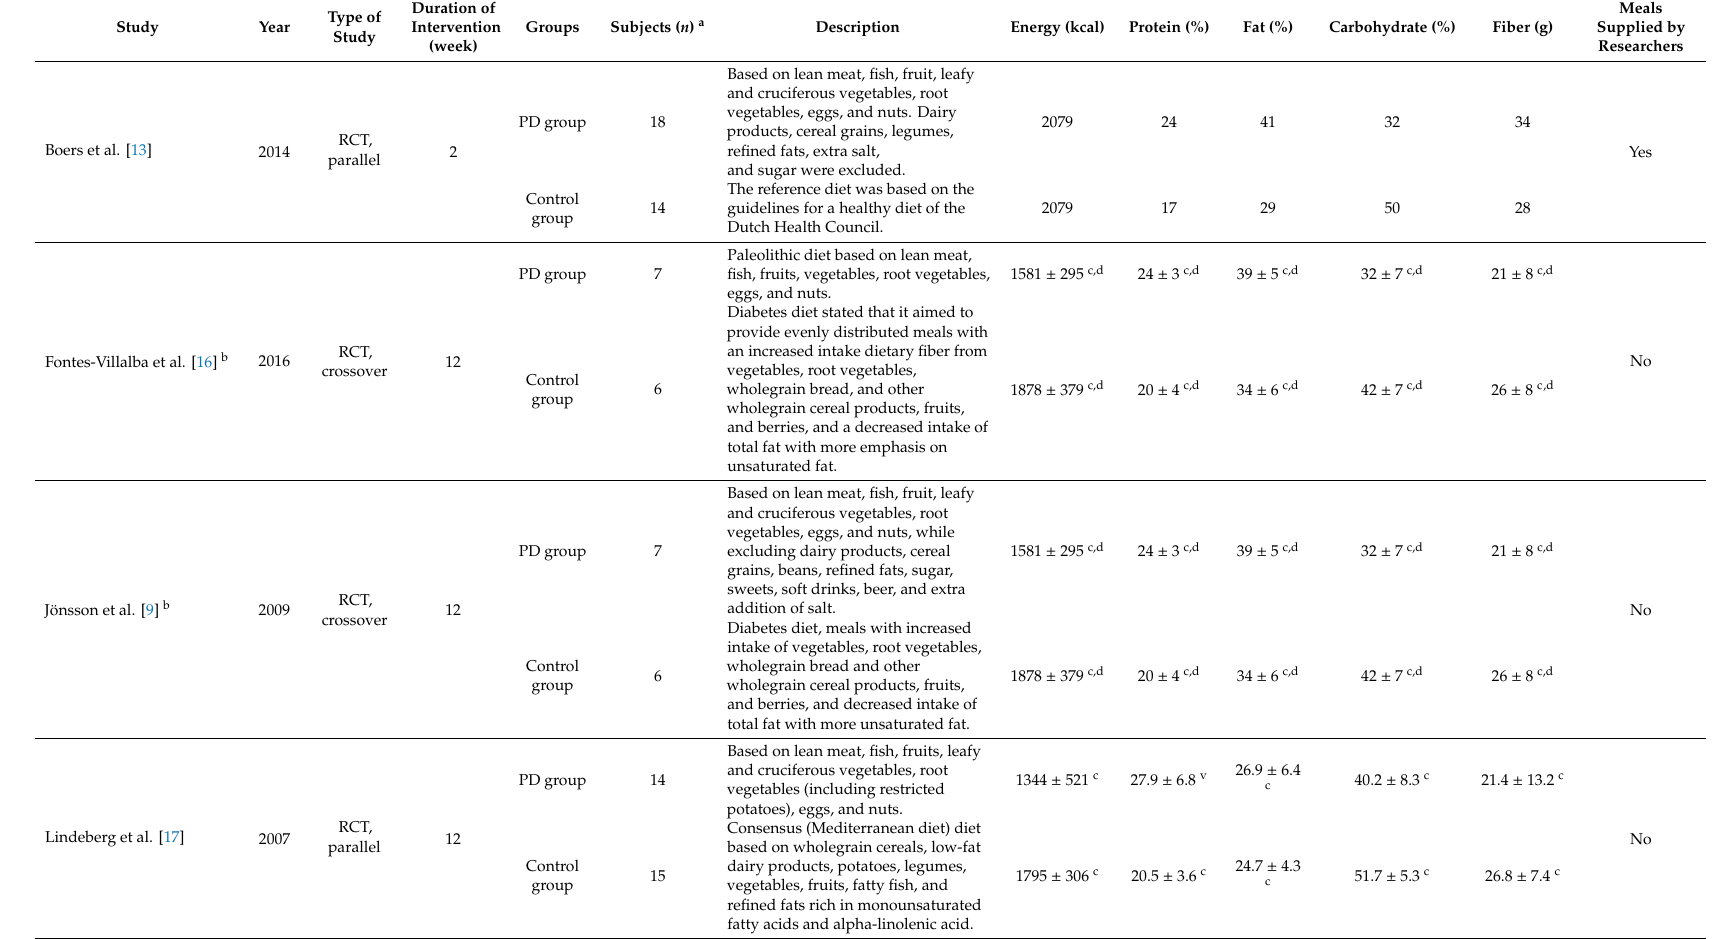
Table 1. Nutrient and caloric composition of the dietary